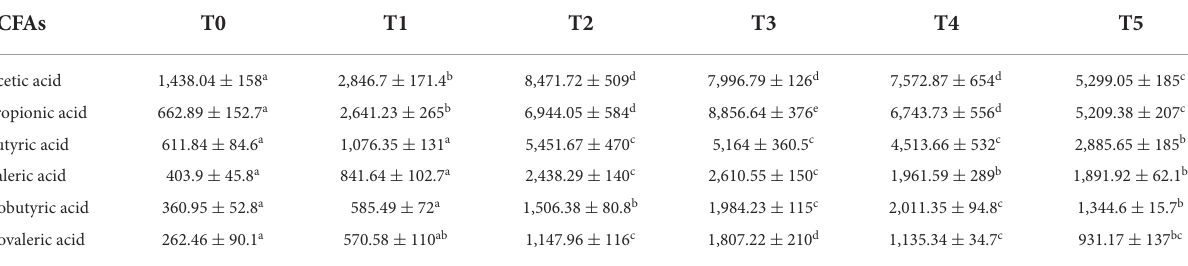
TABLE 6 Effects of adding CAP level ( µ g/L) on SCFAs in the intestine of white-feather broilers (means ±